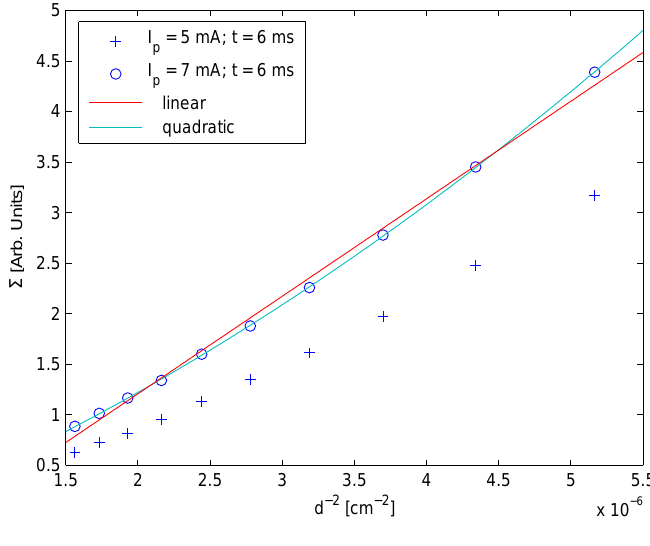
Figure 8. The standard deviation as a function of d (cid:0) 2 . From the behavior of (cid:6) with d it can be stated that considering quadratic behavior is more accurate than linear